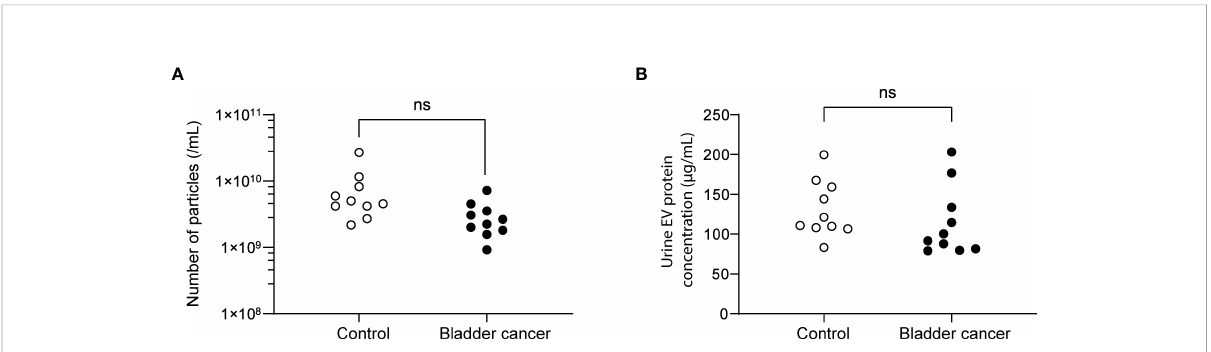
FIGURE 3 Analysis of the particle number and total proteins of uEVs from control and bladder cancer patients. (A) the particle numbers of uEVs were analyzed by a nanoparticle tracking analyzer, ZetaView. (B) total protein concentrations were analyzed by micro BCA. ns, not signi fi